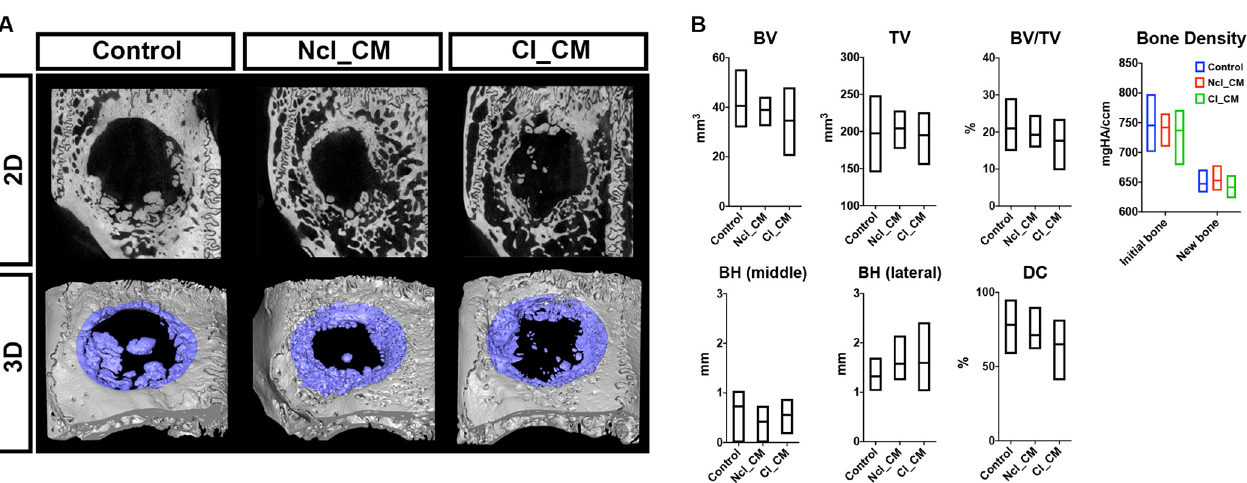
Figure 4. The micro-CT analysis. ( A ) Representative images of the micro-CT data in each group; the 2D plane (upper row) and 3D-reconstructed views (lower row; the blue color shows new bone in VOI). ( B ) The quantified data of the micro-CT analysis. Bone volume (BV, mm 3 ), total volume (TV, mm 3 ), BV/TV (%), bone density (mmHA/ccm), bone height (BH, mm) in middle area, BH in lateral area, and defect closure (DC, %) were calculated in each group at three months post-surgery. No significant differences were observed in any parameters among the tested groups.